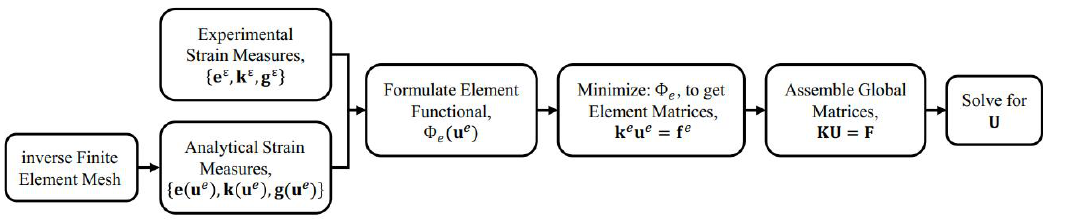
Figure 2. Flow chart of the iFEM procedure.